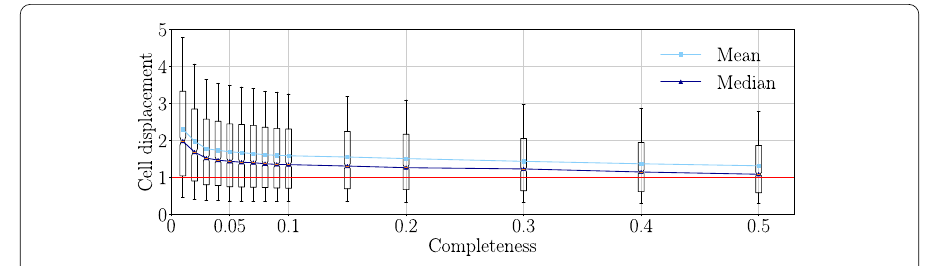
Figure 8 Performance of CTR in cell displacement. Cell displacement of locations inferred via CTR with respect to the actual ones, versus the completeness of the original trajectory. Candlesticks highlight the mean (light blue), median (dark blue), 25 th and 75 th percentiles (box), and 10 th and 90 th percentiles (errorbars). The horizontal line (red) highlights a one-cell